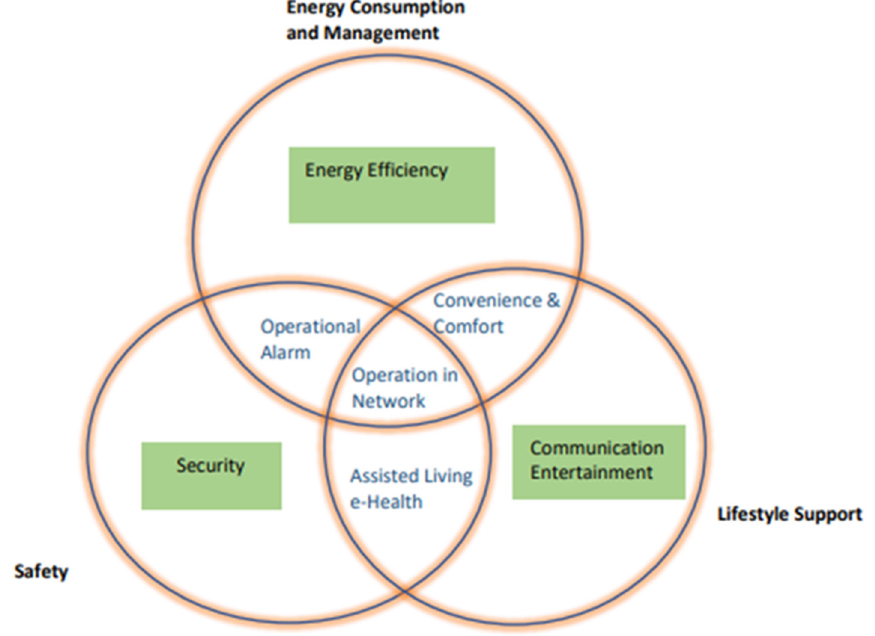
Figure 7. Smart homes/building